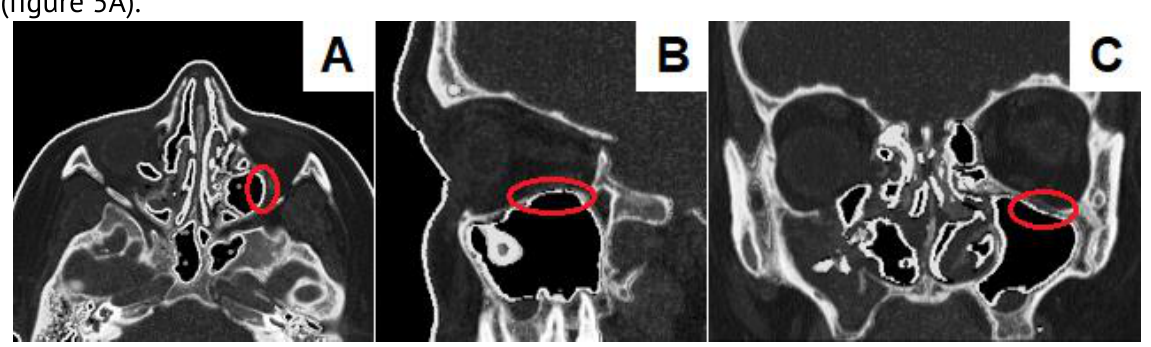
Figure 5. Three projections of the patient's head, constructed on the basis of the original DICOM images converted by special software: a – axial orientation; b – sagittal orientation; c – coronal orientation.